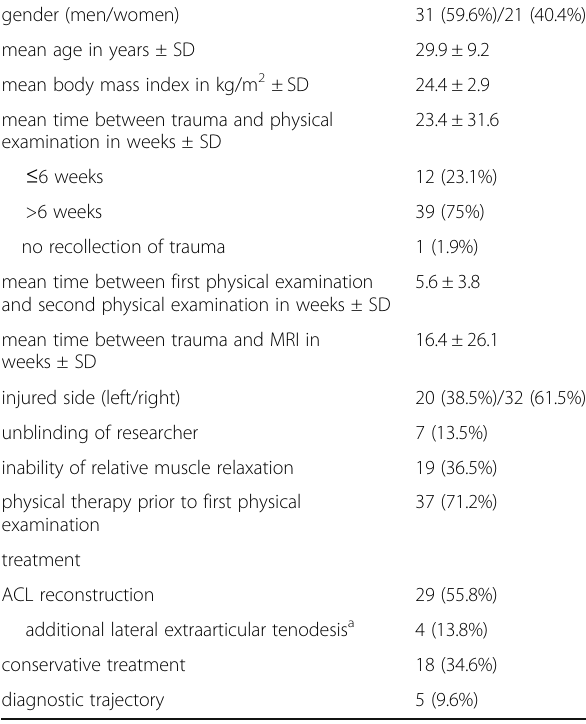
Table 1 Patient characteristics of 52 patients gender (men/women)